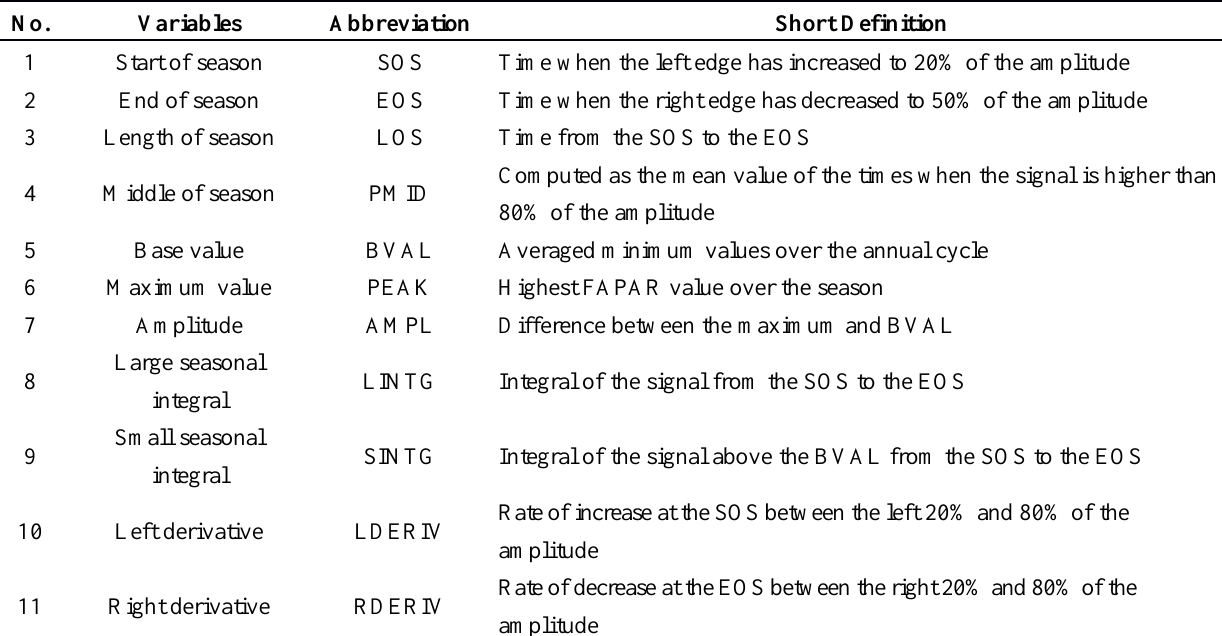
Table 2. Phenological metrics derived from the FAPAR time series (extracted using TIMESAT